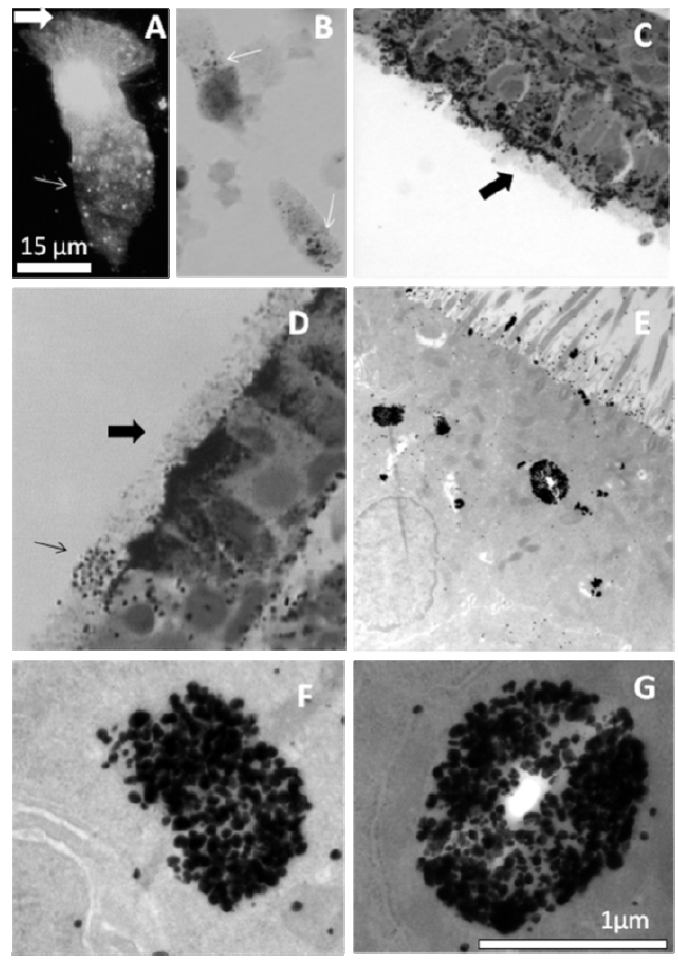
Figure 1. Zinquin fluorescence and autometallography of metal ions in apical cytoplasm of airway epithelium (AE) ( A ) Labeling of labile Zn by Zinquin in a typical human ciliated bronchial epithelial cell. Note the intense fluorescence in the apical cytoplasm, fluorescence in cilia (thick arrow) and vesicular-like fluorescence extending into the basal region of the cell (thin arrow); ( B ) In vitro silver enhanced ZnSe nanocrystals (thin arrows) in the apical cytoplasm of pig tracheal epithelial cells; ( C – G ) In vivo Se-AMG-stained rat tracheal epithelium. Note the labeling of Zn ions in the cytoplasm below the cilia (thick arrow). In one of the AE cells (Panel D, thin arrow), Zn ions are largely absent from the cytoplasm, but seem to have moved out of the cell and onto the surfaces of the cilia. In panels E–G, typical transmission electron micrographs show clusters of zinc-selenium nanocrystals in the apical cytoplasm and around the cilia. Some clusters (e.g., panel G), show a structure that appears to be enclosed by a membrane and to contain a hollow core surrounded by metal